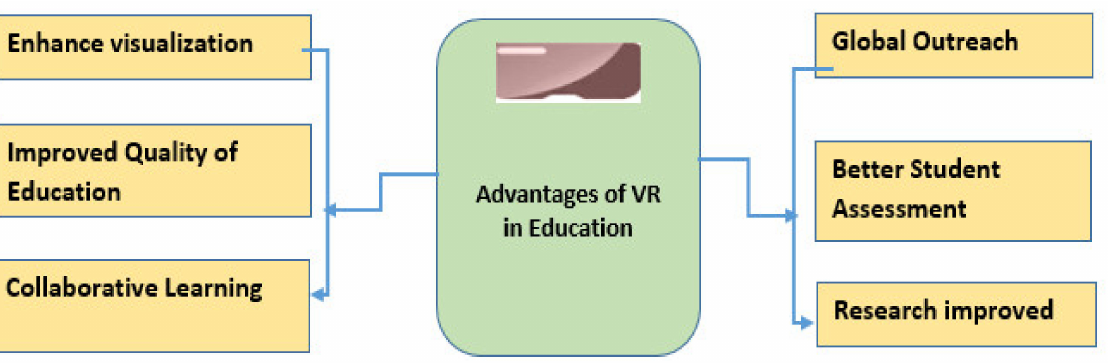
Figure 7. Fifth-generation and virtual reality (VR) in smart education